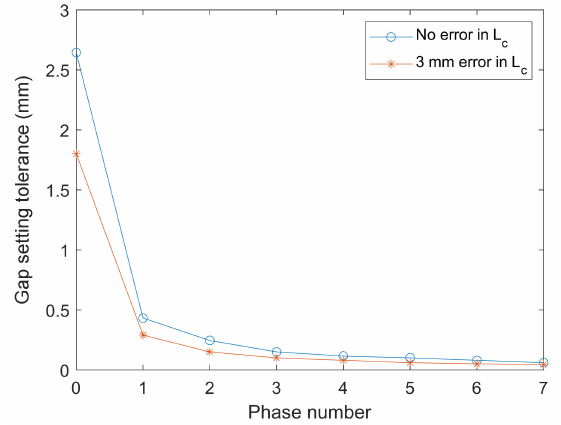
Figure 11. The phase-shifter gap setting tolerance allowing the 5% reduction in FEL intensity as a function of phase